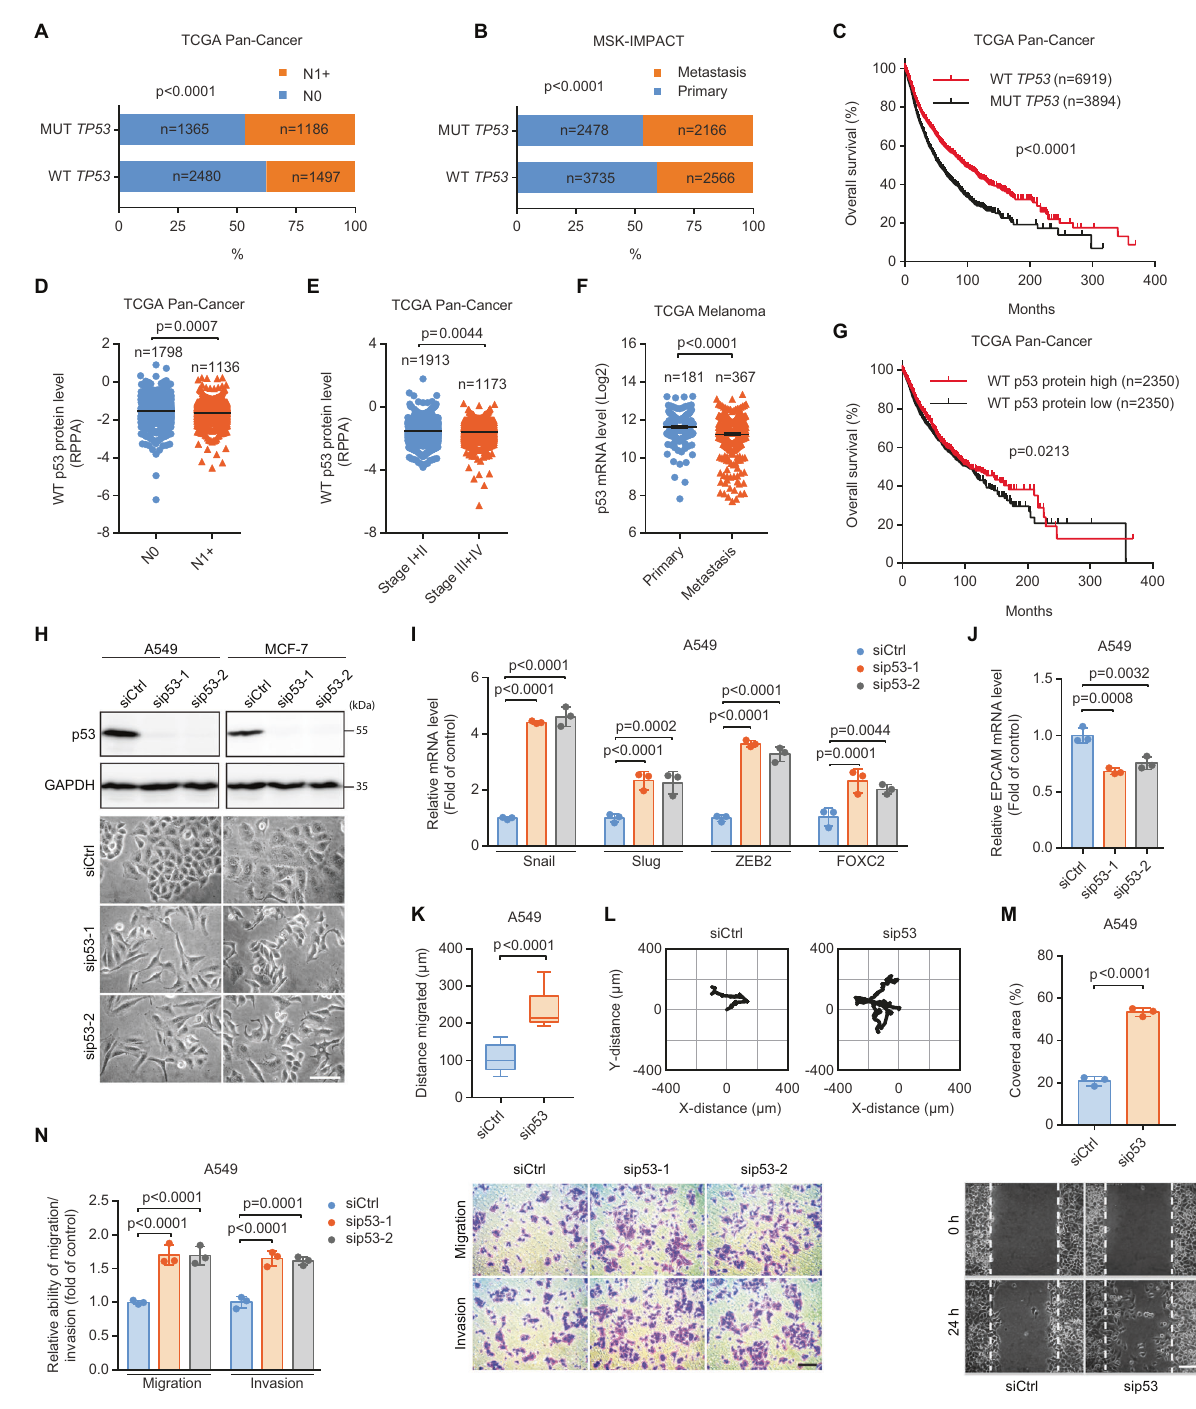
(Fig. 1B) as compared to those having WT TP53 . In addition, median overall survival was over 1.7-fold longer in patients with WT TP53 than in those with MUT TP53 (Fig. 1C). Most TP53 mutations in human cancers are missense mutations [29 – 31]. Missense mutations in the TP53 gene not only abrogate the normal tumor-suppressive functions of WT p53 but also exert novel oncogenic gain-of-function activities that exacerbate cancer develop- ment and metastasis [30, 32]. A closer analysis of the associations between different TP53 subtypes and lymph node metastases showed that the group of TP53 unaltered cancer patients displayed